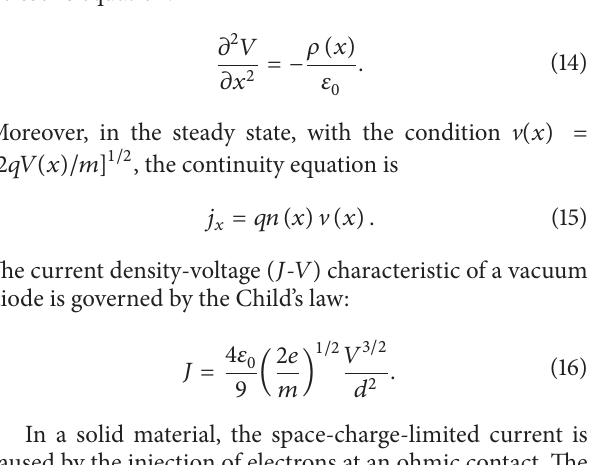
Figure 21: Linear relation between current density and electric field at temperature ranging from 25 to 150 ∘ C in low resistance state in Pt/ZnO/Pt memory devices.